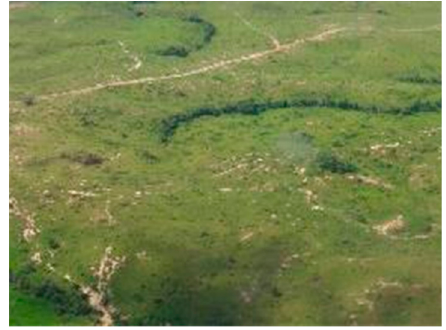
Figure 3. Degraded area before the start of the reforestation program.